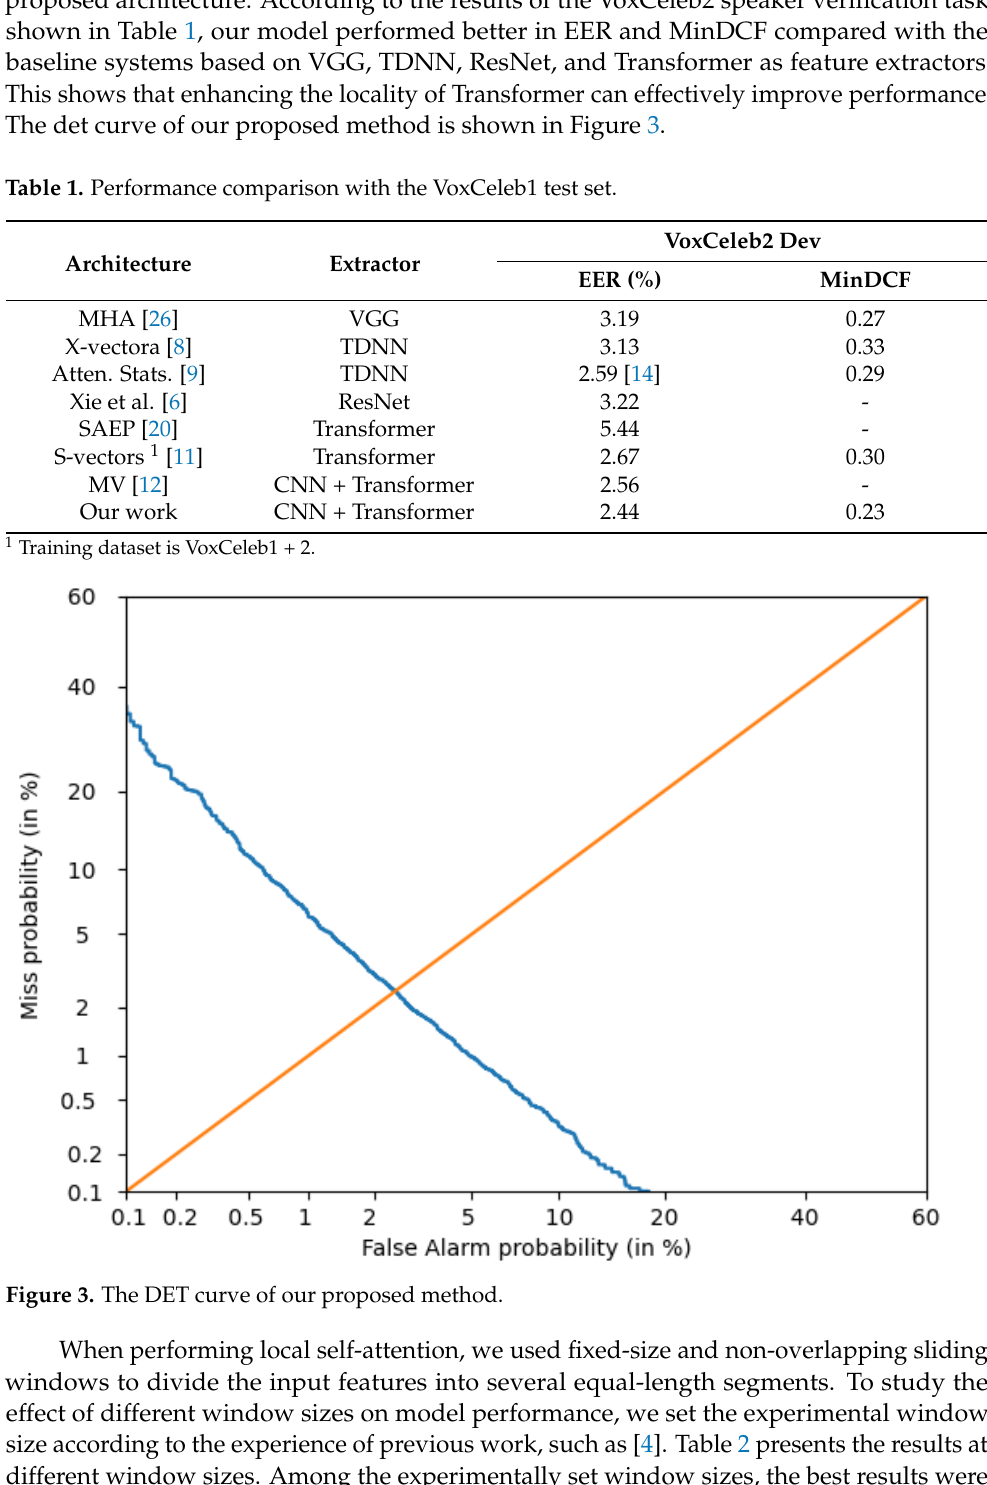
Table 3. Ablation study of our proposed